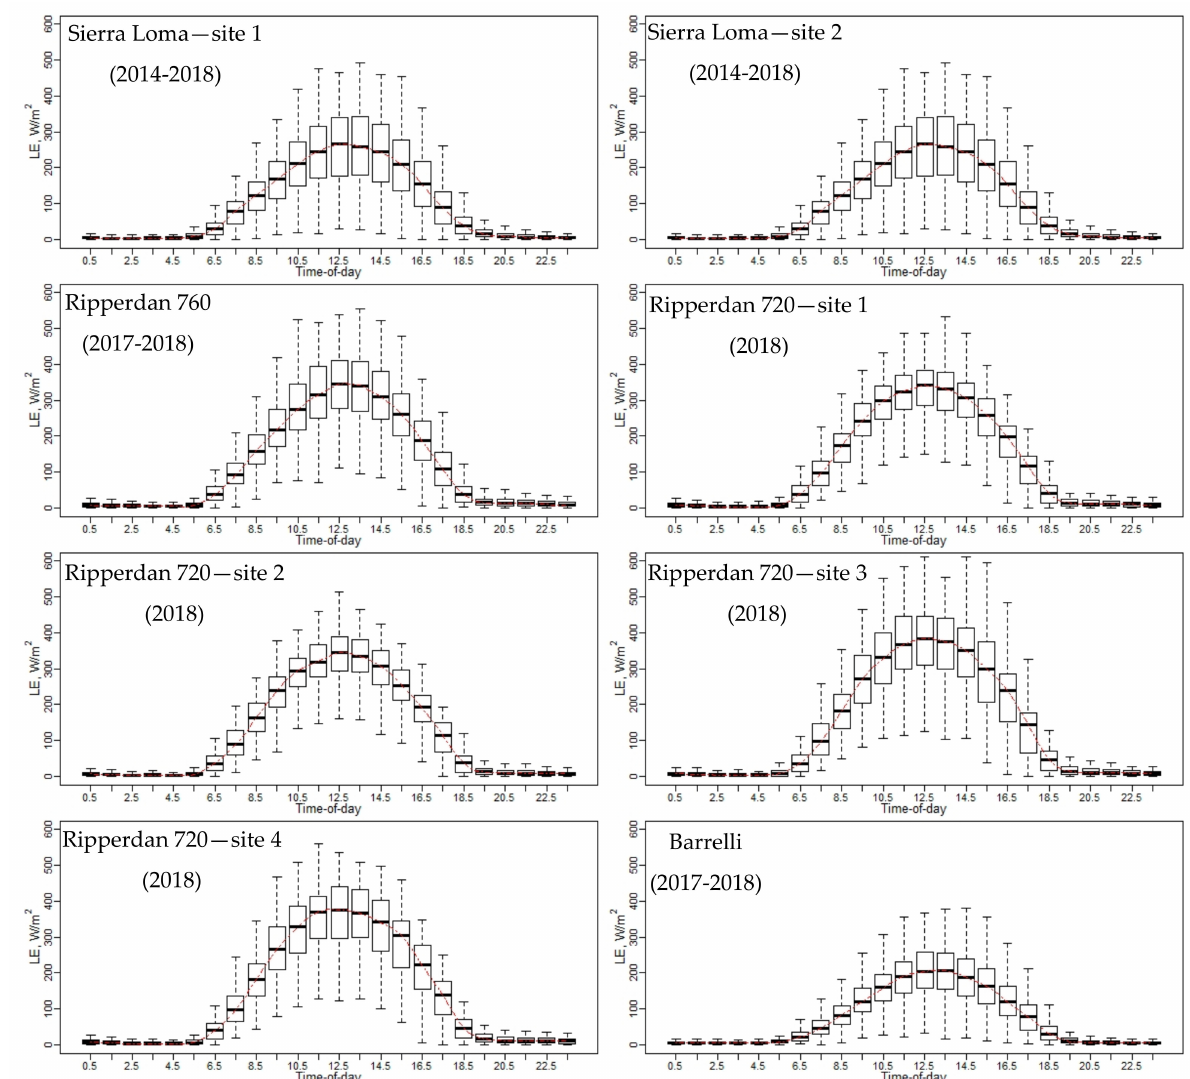
Figure 5. Diurnal variations of LE for each EC included in this study for the years 2014 to 2018, from the April to October irrigation